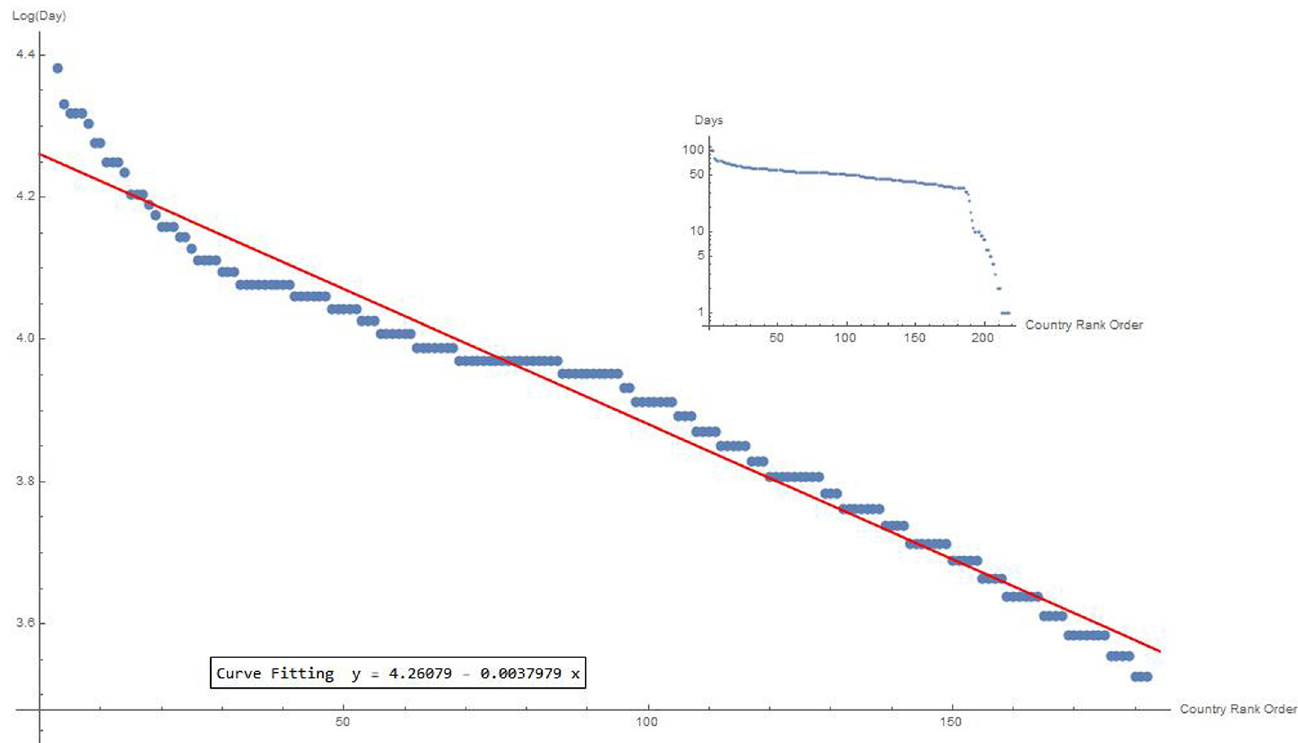
Fig 4. Starting day distribution for each country over time. Realized on a logarithmic scale, this distribution intercepts an exponential law dynamics. The regression curve value is y = 4.26–0.0038x.